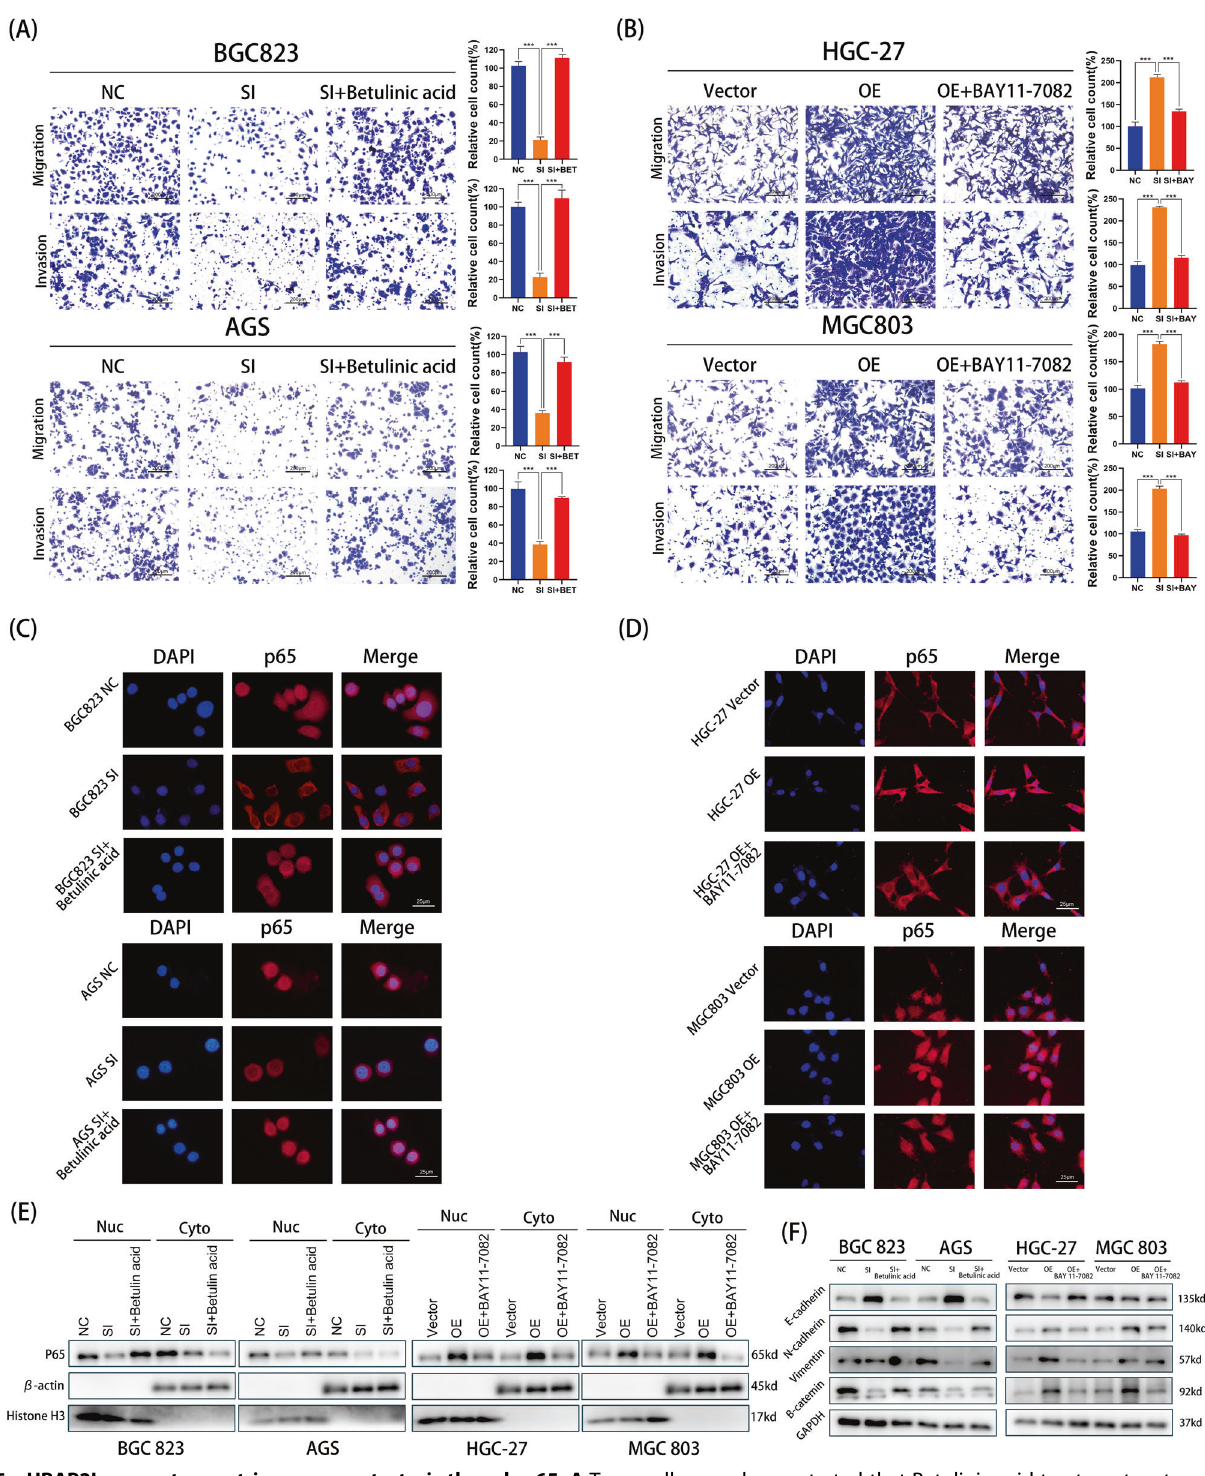
Fig. 5 UBAP2L promotes gastric cancer metastasis though p65. A Transwell assay demonstrated that Betulinic acid treatment restored the migration and invasion ability of GC cells damaged by siRNA. B BAY11-7082 notably weakened the UBAP2L-induced upregulation in the ability of migration and invasion. C , D IF displayed that Betulinic acid reversed the activation of p65 attenuated by UBAP2L knockdown and BAY11- 7082 suppressed the activation of p65 evoked by overexpression. E The expression of nuclear p65 and cytoplasmic p65 were evaluated by western blot in BGC823 and AGS treated by siRNA plus Betulinic acid as well as HGC-27 and MGC803 infected UBAP2L lentivirus plus BAY11- 7082. F The variation of EMT markers after Betulinic acid or BAY11-7082 treatment.